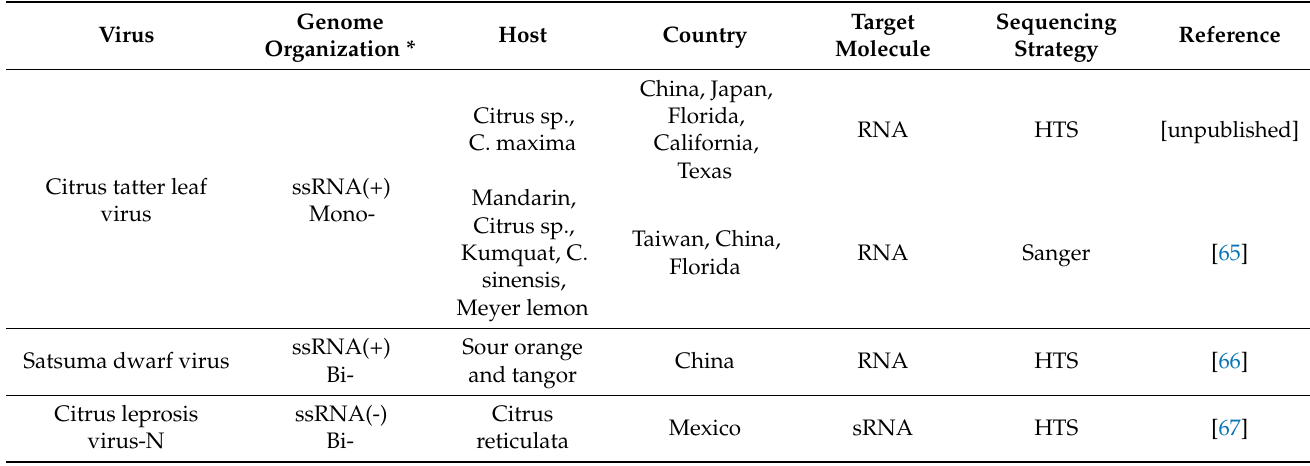
Table 2. Relevant data of complete genome sequences of the main exotic and emergent citrus viruses relevant for the Mediterranean in addition to citrus tristeza